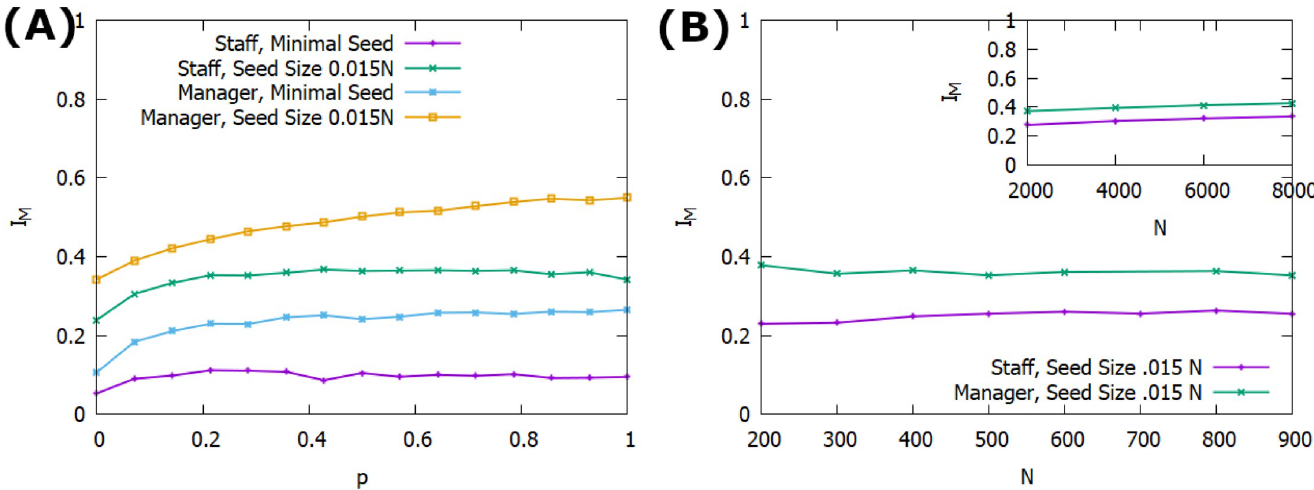
Fig 3. Synthetic network spread. Plot of average max adoption over 1000 runs. I is the maximum adoption, p is the probability of connection for every pair of M managers, and N is the overall system size. Management connections are made via ER random graph method. A: Average maximum adoption versus management connection density over 1000 runs. B: Average maximum adoption vs sysem size. Seed size is proportional total network size, set at 1.5% of the network. All networks have a number of managment communities c = 0.06 N and an average node degree of h k i = 20.